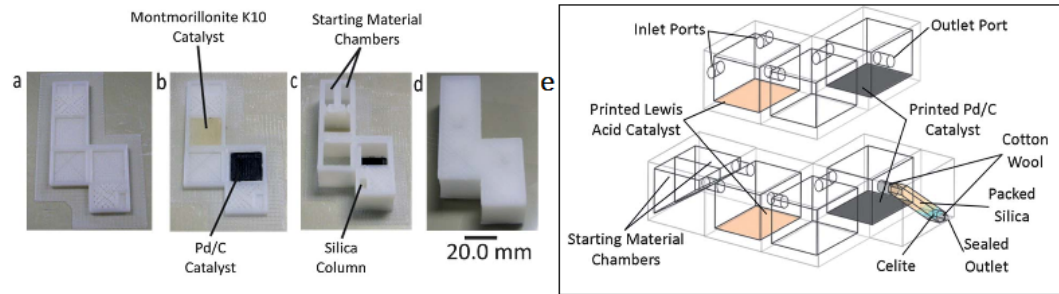
Figure 18. ( a ) Reactor base with purification column before printing of catalyst regions; ( b ) Reactor base with purification column after printing of catalyst regions; ( c ) Fabricated reactor with purification column after addition of starting materials, reagents, and packing of silica; ( d ) Final sealed reactor; ( e ) Schematic diagram of the 3D ‐ printed sequential reactors. (Reproduced with permission from [31].) Additively manufactured droplet generators for programmable liquid handling and control of biological samples were also demonstrated [24]. Mono-disperse droplets of water-in-oil (W/O) were generated, which included a sensor-integrated chamber for online monitoring of cellular growth.